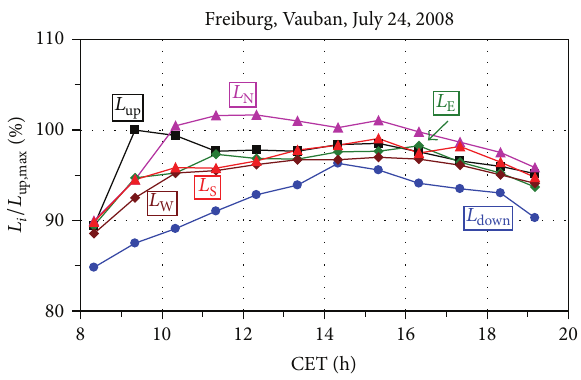
( 𝐾 = Figure 18: 1h mean values of the long-wave radiant flux den- down down , max sities 𝐿 𝑖 ( 𝑖 = down, up, E, S, W, and N) reaching the human- biometeorological reference person from the three-dimensional environment, related to the 1h peak value of 𝐿 474 W/m 2 ), SSW-facing sidewalk (shaded by tree canopies) of a WNW-ESE street canyon, “Vauban” quarter in Freiburg during typical Central European summer